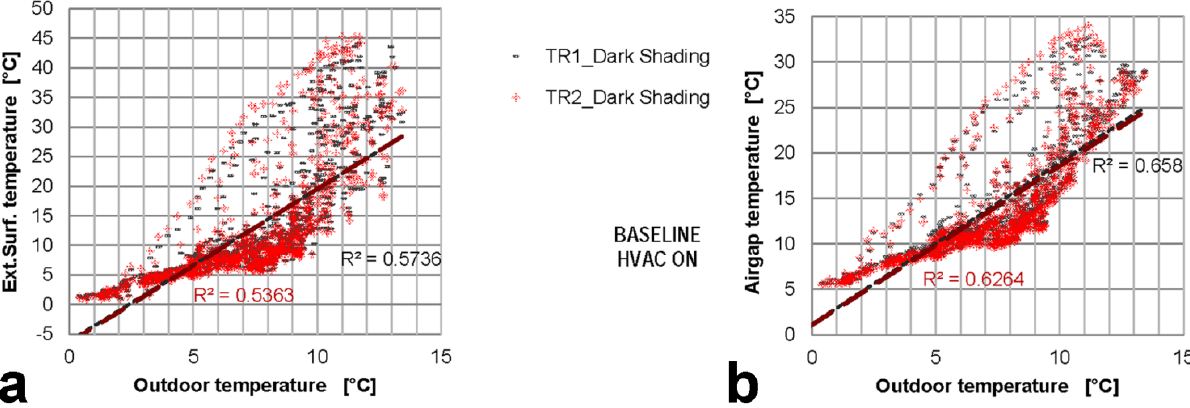
Figure 3. Thermal profiles of the monitored test-rooms during the baseline characterization.